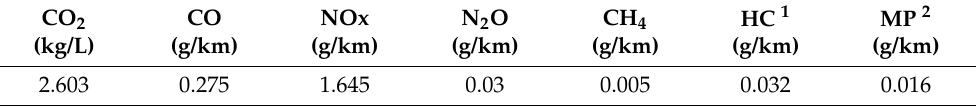
Table 4. Atmospheric emission factors for semi-heavy trucks with diesel